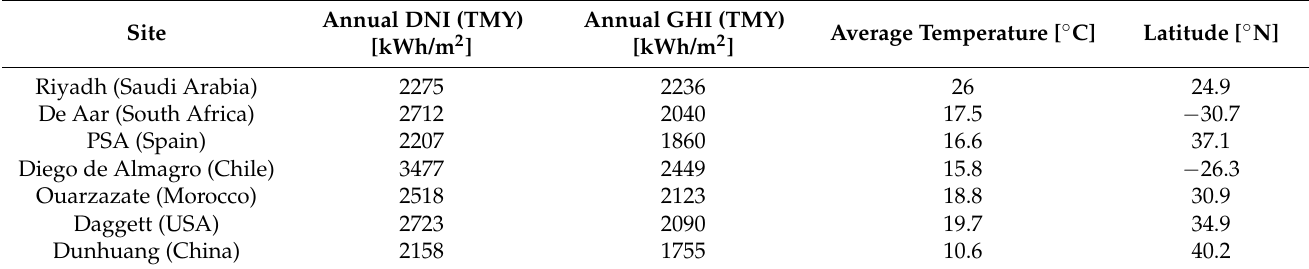
Table 4. Main parameters of the evaluated sites.